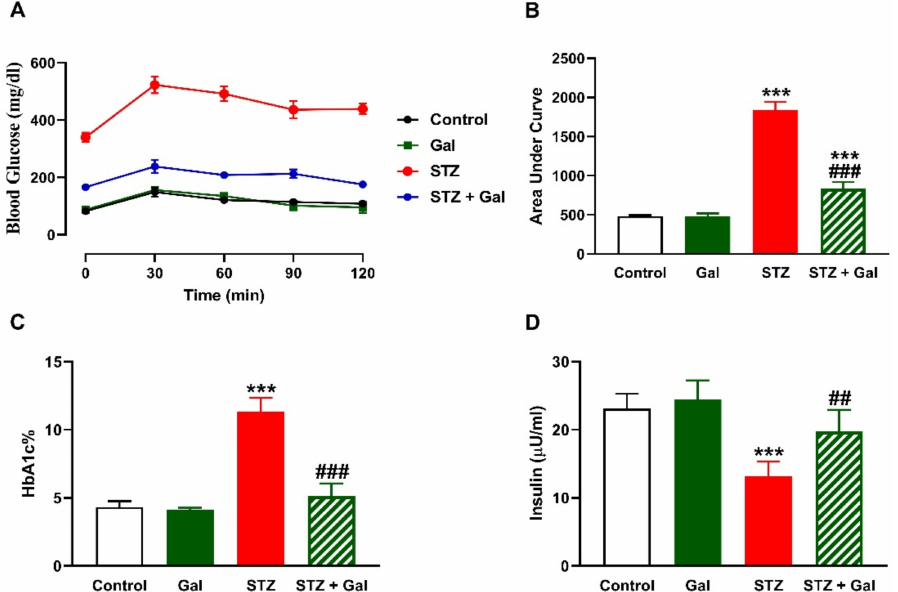
Figure 1. Galangin ameliorates hyperglycemia in diabetic rats. Galangin improved glucose tolerance ( A , B ), decreased HbA1c% ( C ), and increased insulin ( D ) in diabetic rats. Data are mean ± SEM, n = 6. *** p < 0.001 versus control. ## p < 0.01 and ### p < 0.001 versus